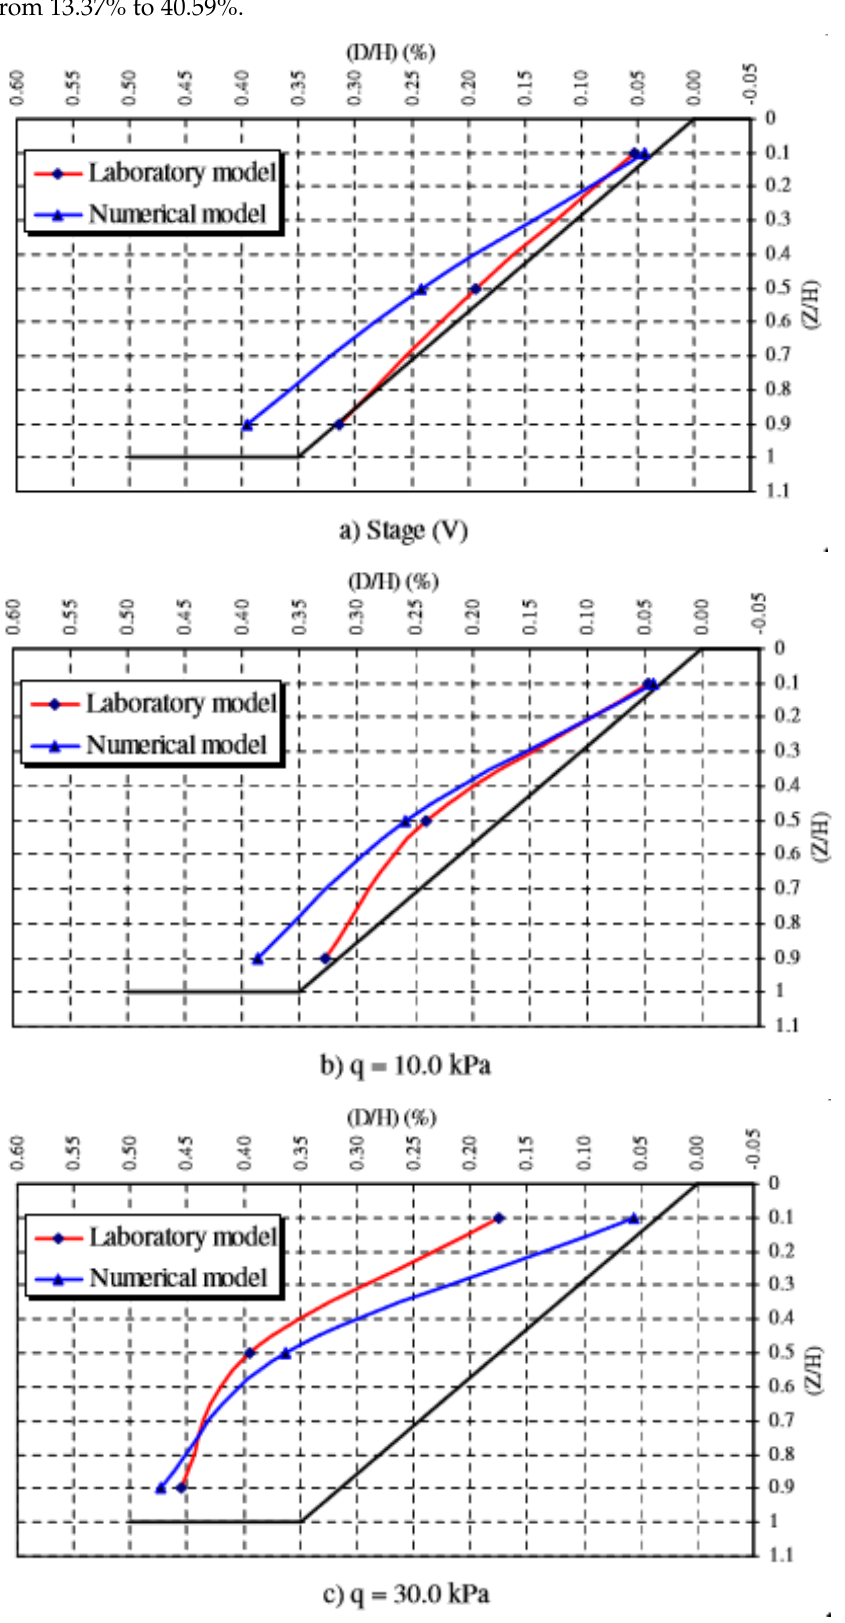
Figure 30. Horizontal slope displacement. The settlement of the footing in the experimental model is also compared with nu- merical results of footing settlement at surcharge pressure of 0, 5, 10, 20, 30 kPa and Figure 31 shows the comparison of the footing settlement obtained in the experimental and finite